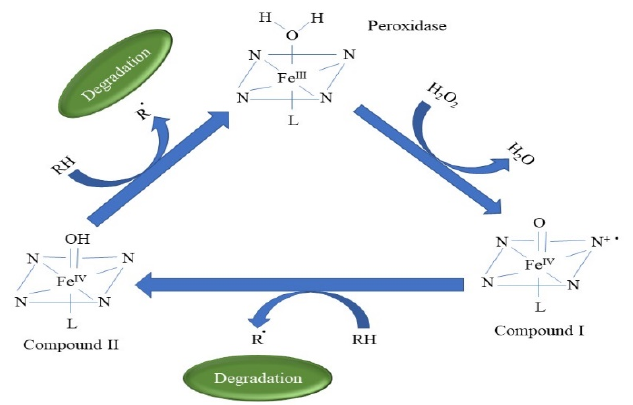
Figure 6. Oxidation mechanism of peroxidase.